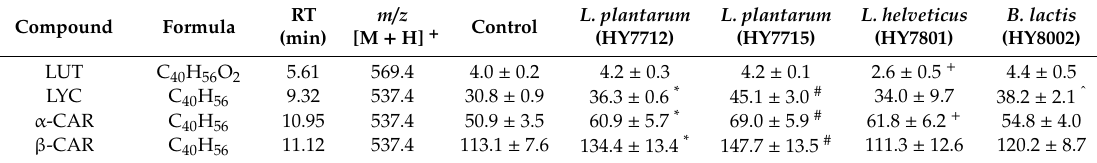
Table 3. Relative levels of carotenoids in the fermented and non-fermented VJs, as detected by LC-MS. Compound